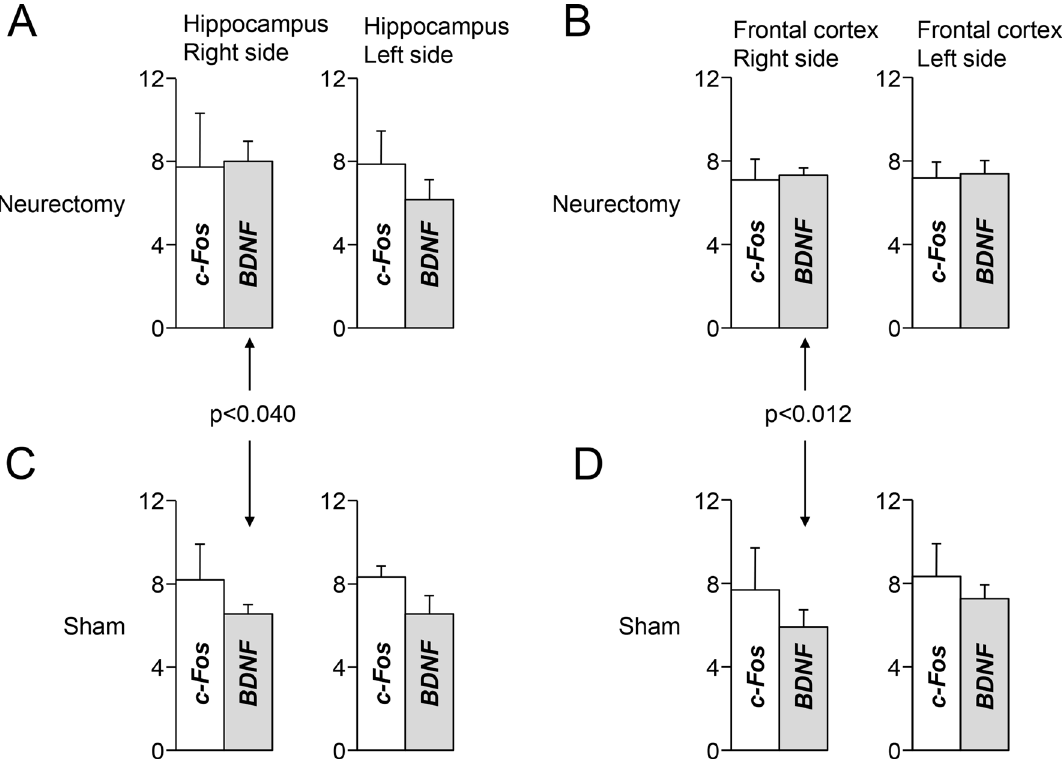
Figure 8. Expression levels of BDNF and c-Fos within the hippocampus and the frontal cortex of trigeminal neurectomy and sham preparations. The height of the white columns represents average ΔCT values evaluated with respect to ACTB (housekeeping gene). Error bars correspond to standard errors. (A,C) Hippocampus. (B,D) Frontal cortex. (A,B) Neurectomy. (C,D)